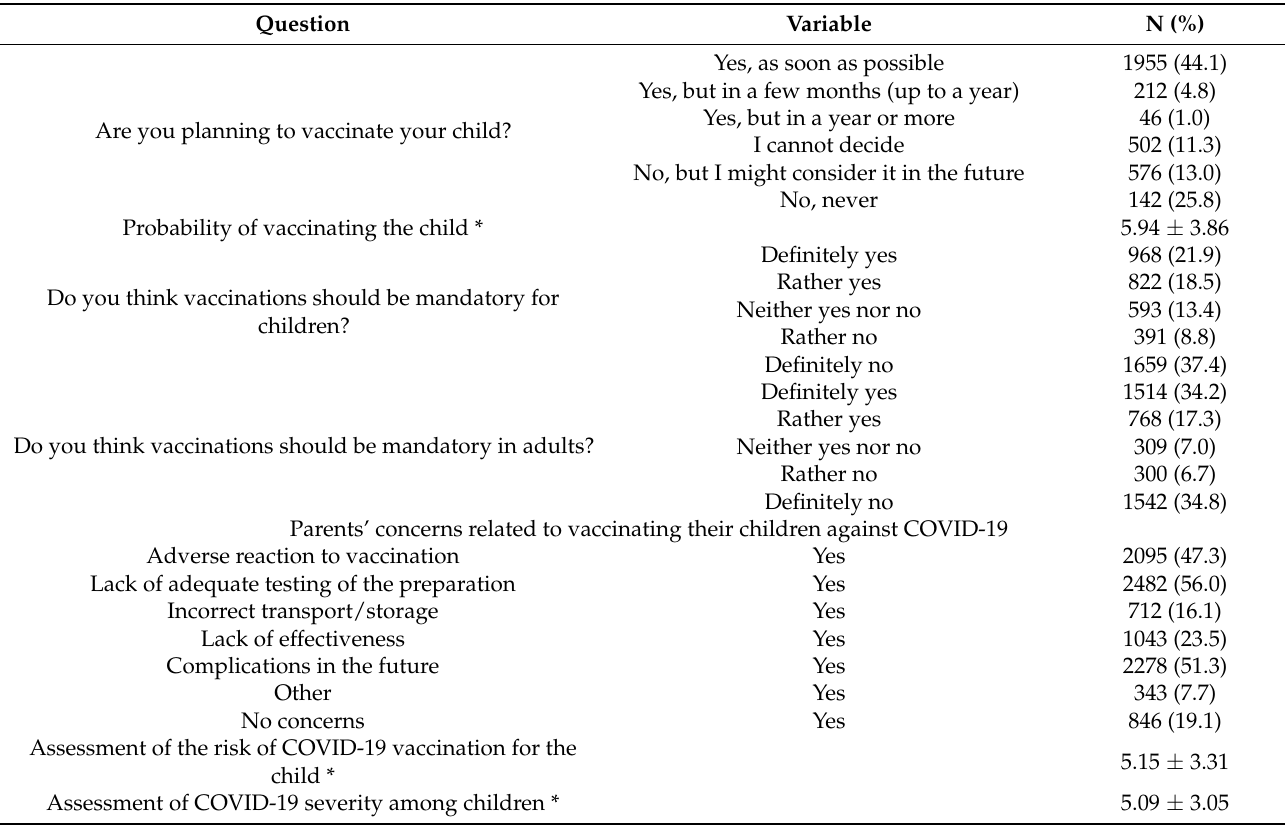
Table 3. Parents’ attitudes toward COVID-19 vaccinations in children with regard to mandatory vaccinations, and major concerns about vaccinations in